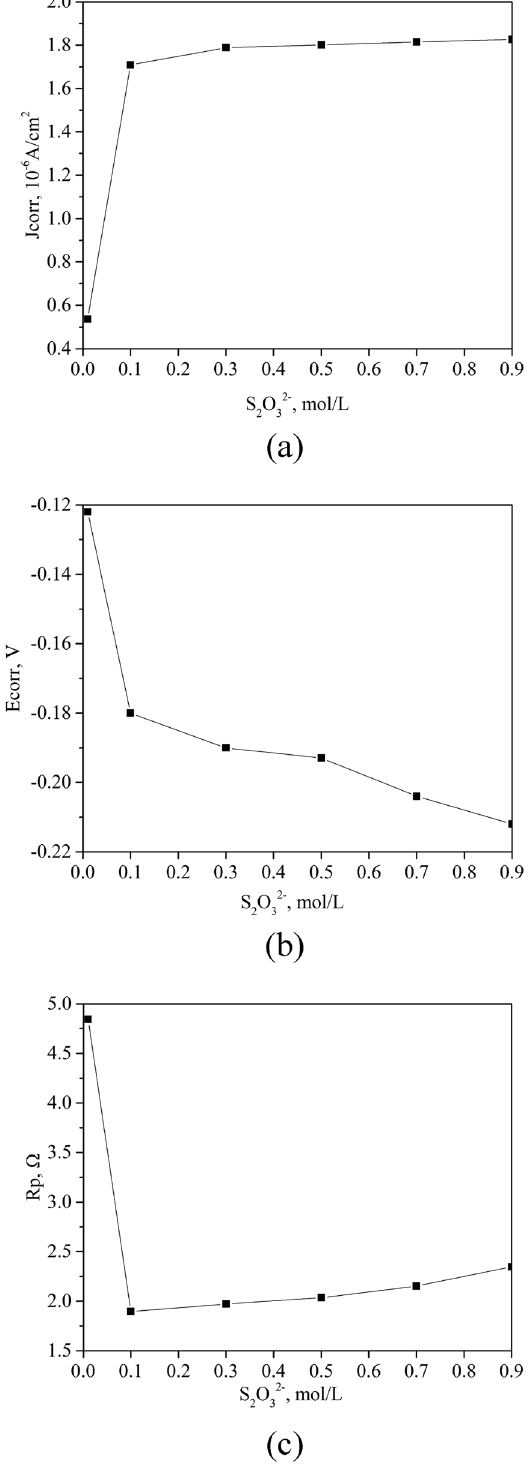
Figure 2: Electrochemical parameters of gold dissolution at di ff erent S 2 O 32 − concentrations: ( a ) corrosion current density of gold dissolution; ( b ) corrosion potential of gold dissolution; and ( c ) polarization resistance of gold dissolution.